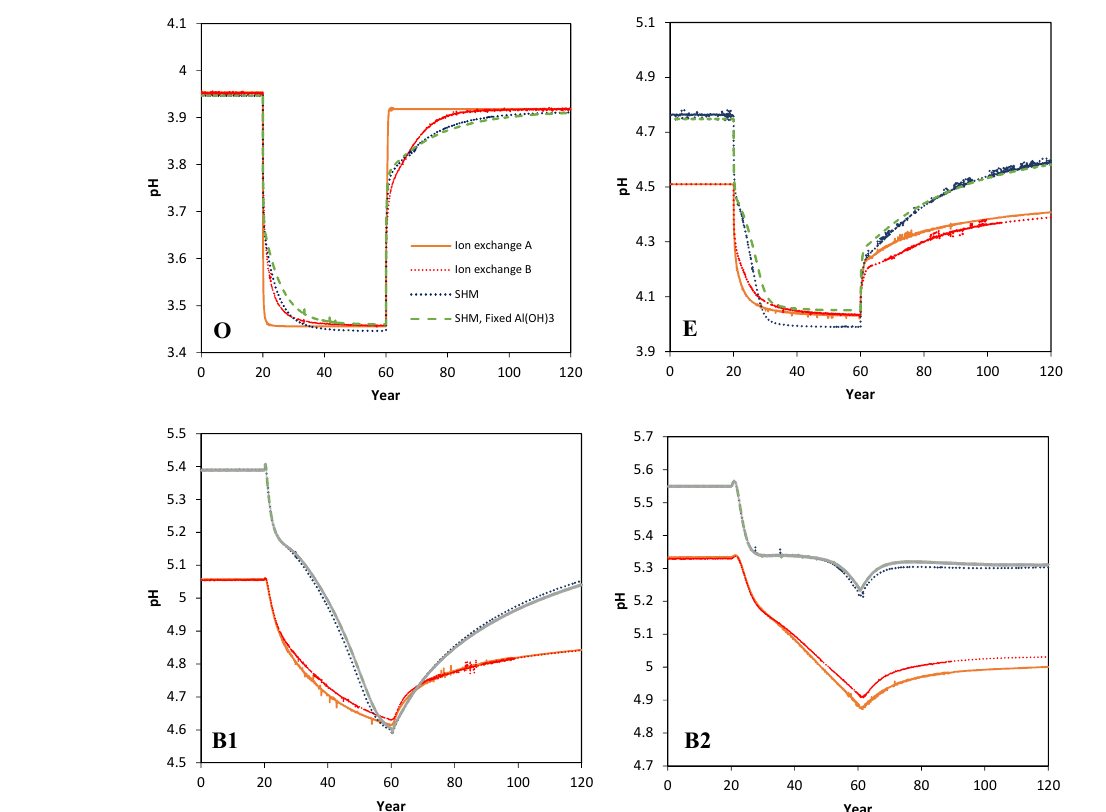
Figure 1. Simulated pH values in the four soil layers (O, E, B1, B2) as a function of time for the four models considered in the Acid scenario. For model set-up and scenario parameters, see